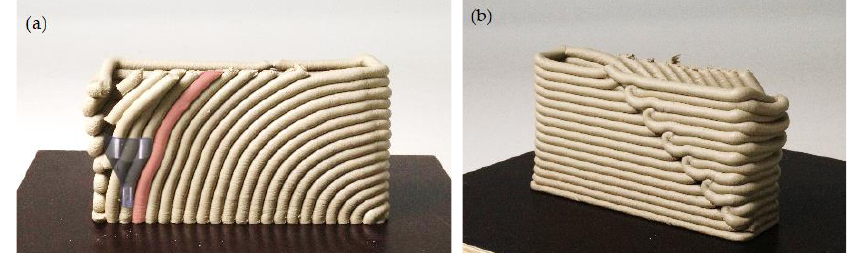
Figure 8. Arc geometry I: front ( a ) and back ( b ).